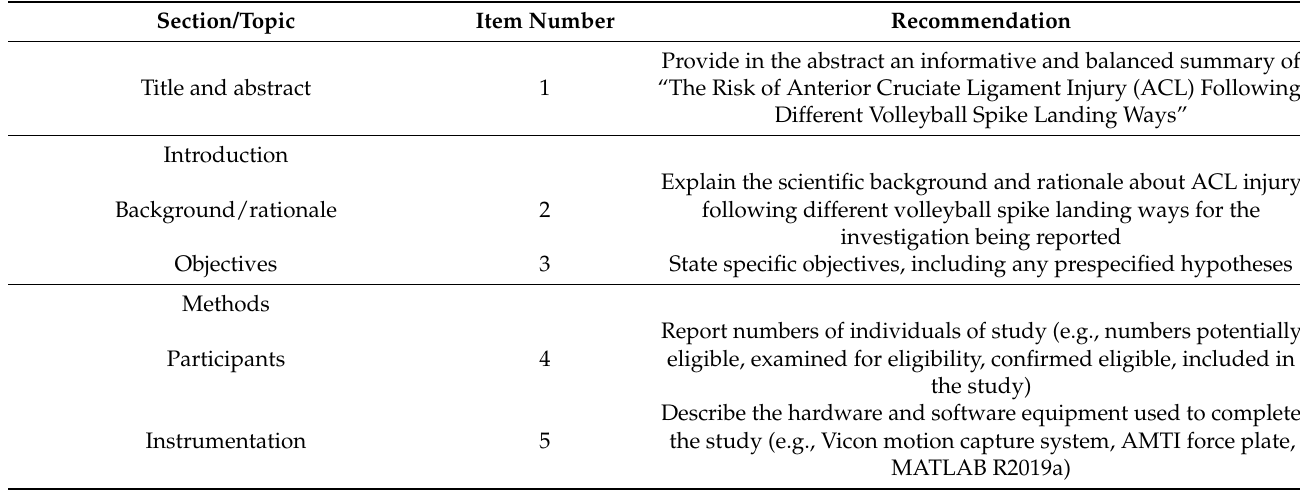
Table A1. An adapted STROBE Checklist for reporting this